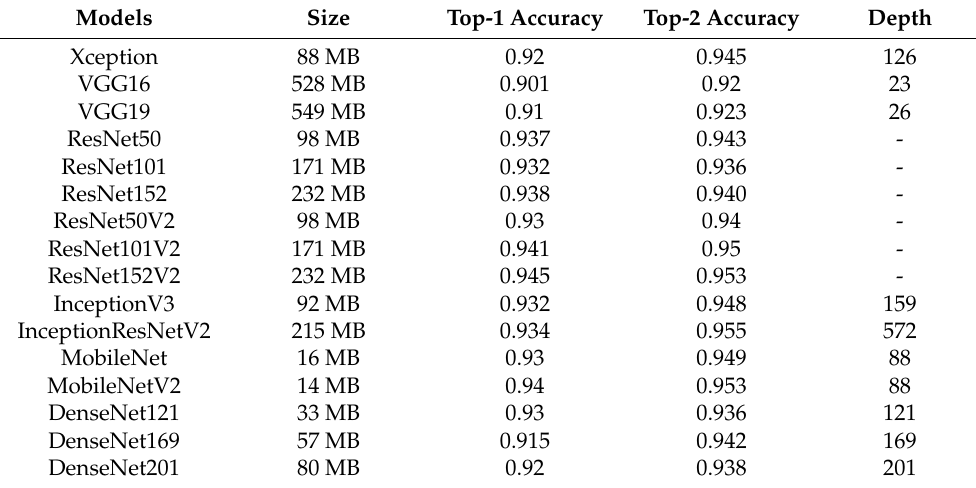
Table 1. Identification statistics of different deep learning models. The Top-1 and Top-2 accuracy refers to the performance of the model on the validation dataset. This includes activation layers, batch normalization layers, etc. Depth refers to the topological depth of the network, which is the number of layers with